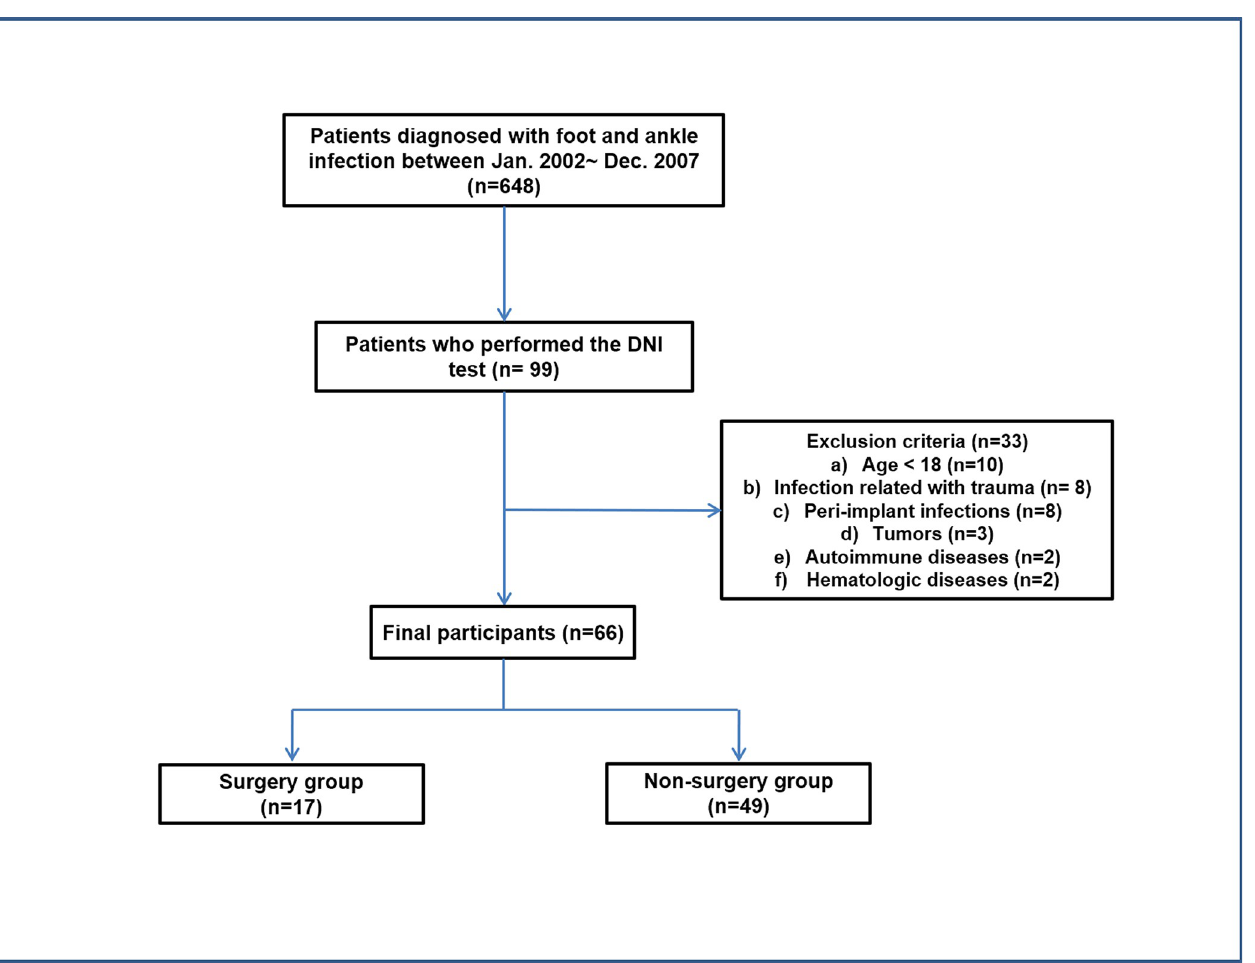
Fig 1. Flow diagram of participant